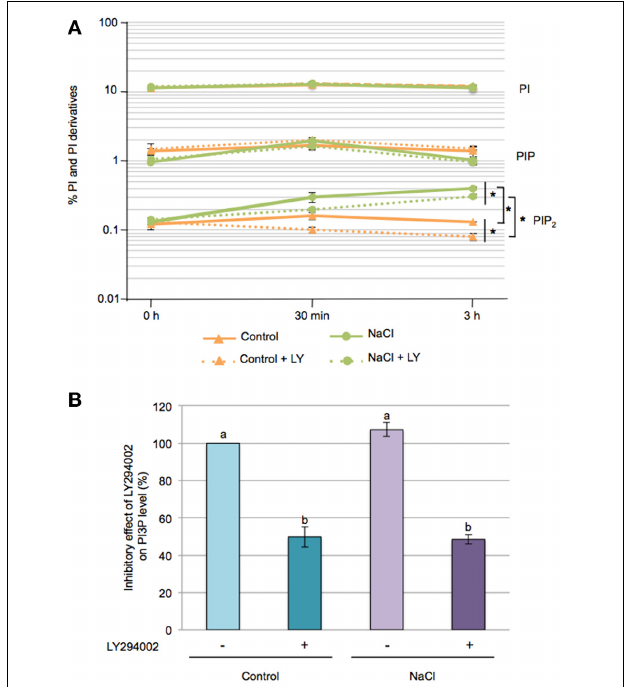
FIGURE 2 | Effect of LY294002 on the levels of Phosphatidylinositol and its derivatives upon salt stress. Five-days-old seedlings were labeled overnight with 32 P i , pre-incubated for 1h with 100 µ M LY294002 or with DMSO, then were stressed with 200mM NaCl for 30min or 3h in the presence ( + LY) or absence of LY294002. (A) Lipids were extracted, separated by TLC and quantified by PhosphoImaging. Data are expressed as percentages of PI, PIP and PIP 2 of total 32 P-phospholipids and are means ± SD of three independent samples containing three seedlings each. A semi-log scale was used for the representation. Significant differences between seedlings treated with or without 100 µ M LY294002 are indicated by *(Two-Way ANOVA test, P < 0 . 05). (B) After TLC separation, PIP spots were scraped-off, deacylated and the resulting GroPInsPs separated by HPLC and quantified by liquid-scintillation counting. The resulting graph represents the variation in PI3P levels at 30min of treatment expressed as a percentage, with 100% corresponding to the control condition without LY294402. Results are means ± SD of three independents experiments. Letters indicate statistical differences in PI3P level depending on treatment conditions (Two-Way ANOVA test, P < 0 .